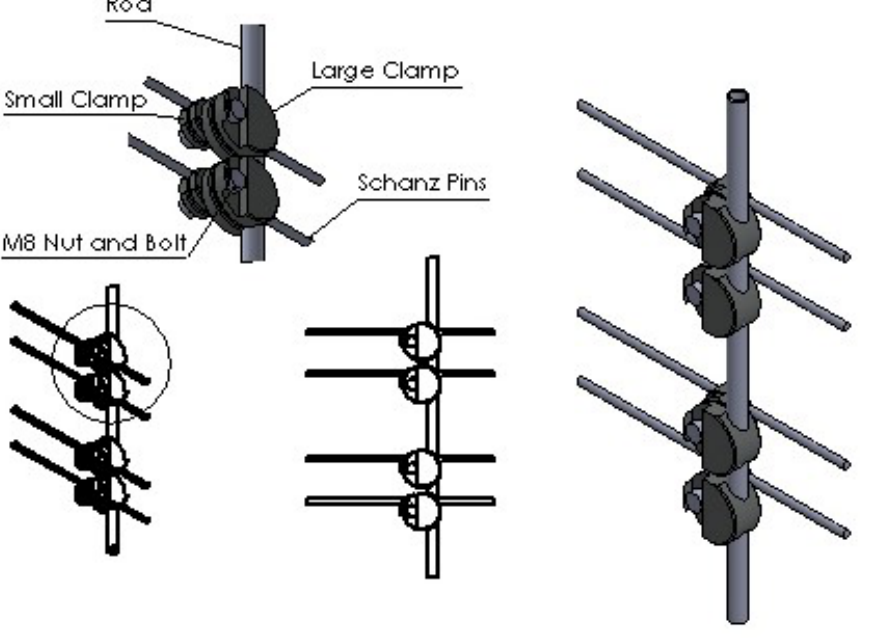
Figure 5. Low cost fixator used for